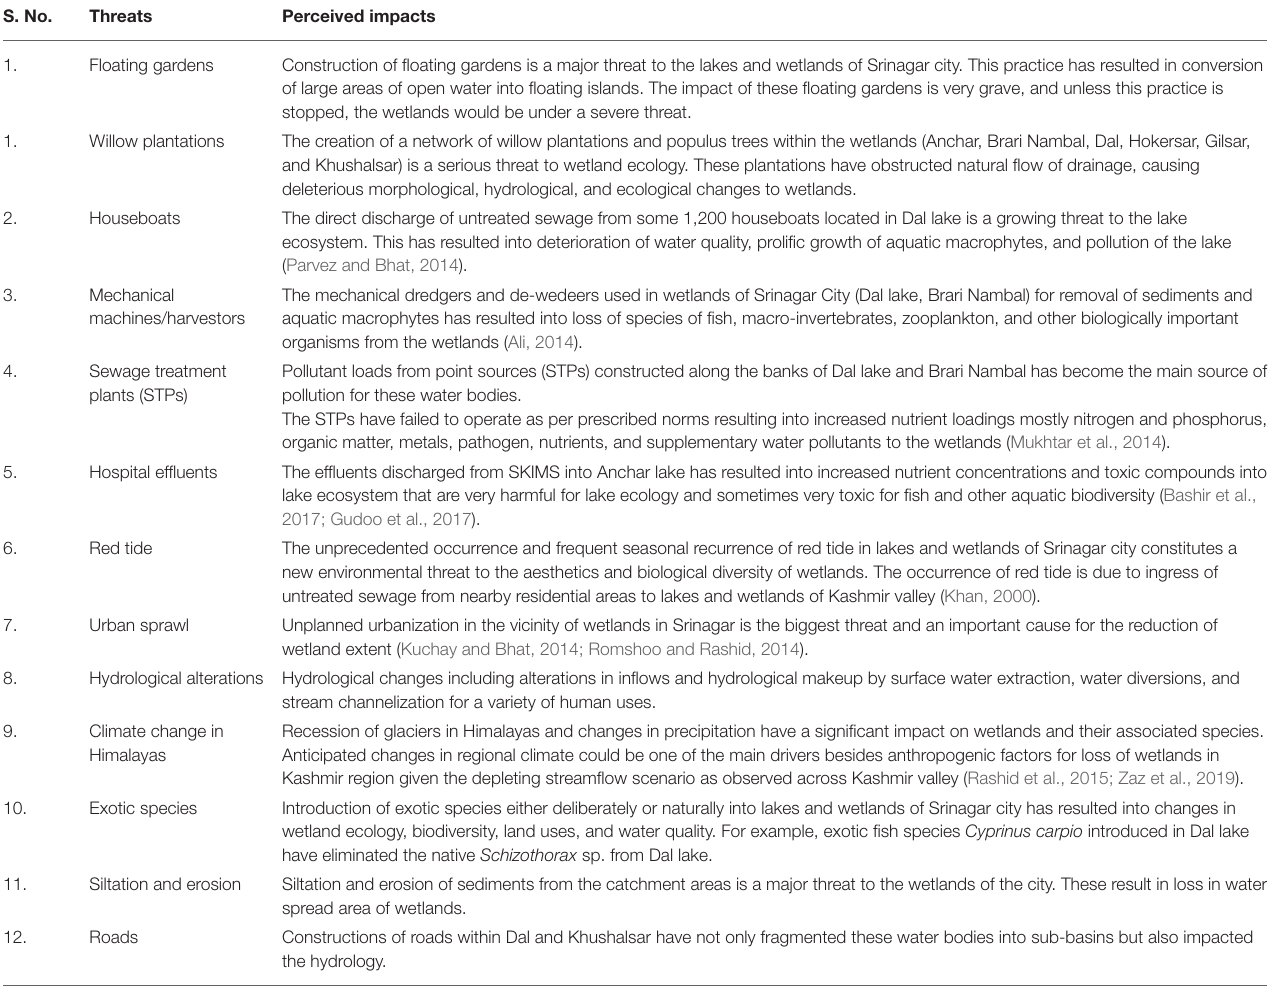
TABLE 8 | Threats perceived by wetlands of Srinagar